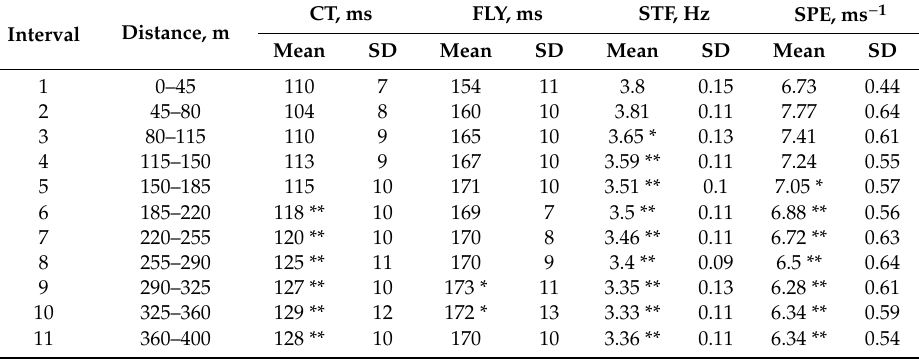
Table 3. Inter-subject mean and SD of the average contact time (CT), flight time (FLY), step frequency (STF), and speed (SPE) within each interval. The results from the one-way ANOVA test, which compared the mean statistics between the second interval and the subsequent ones, are shown with significance level at 0.05 (*) and 0.01 (**).